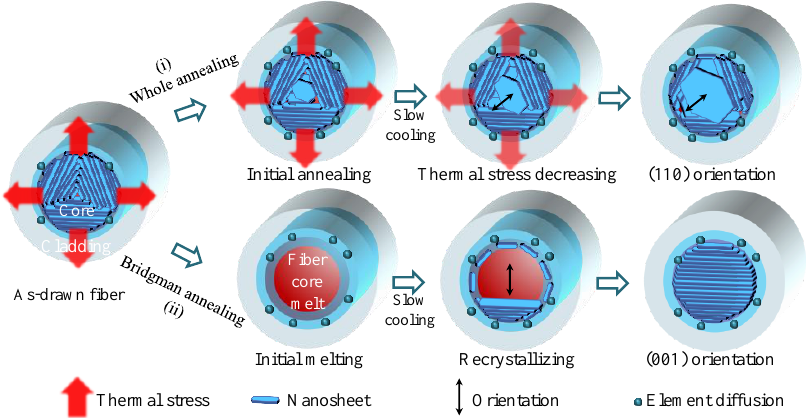
Figure 3. Two oriented crystal growth models of the n-type Bi 2 Te 3 fiber core during whole annealing or Bridgman annealing.